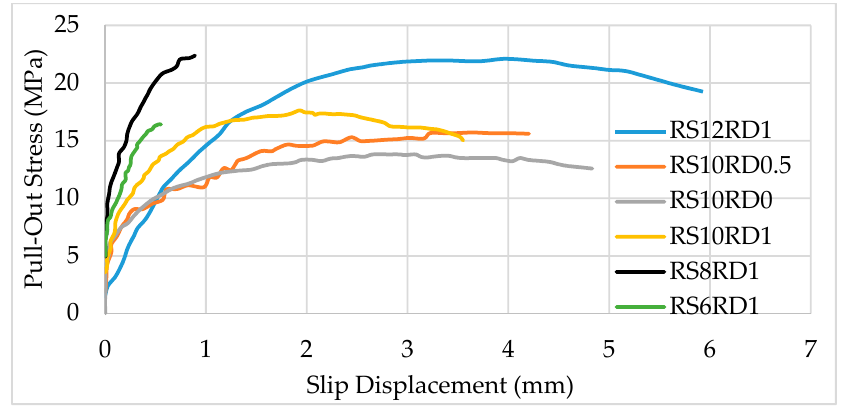
Figure 3. Pull-out test result showing stress versus slip for 10 mm diameter BFRP bars with bond length l = 5D with various rib spacings and rib depths. RS12RD1 = Rib spacing of 12 mm and rib depth of 1 mm. Reprinted with permission from ref. [21]. Copyright 2021 ASTM International.